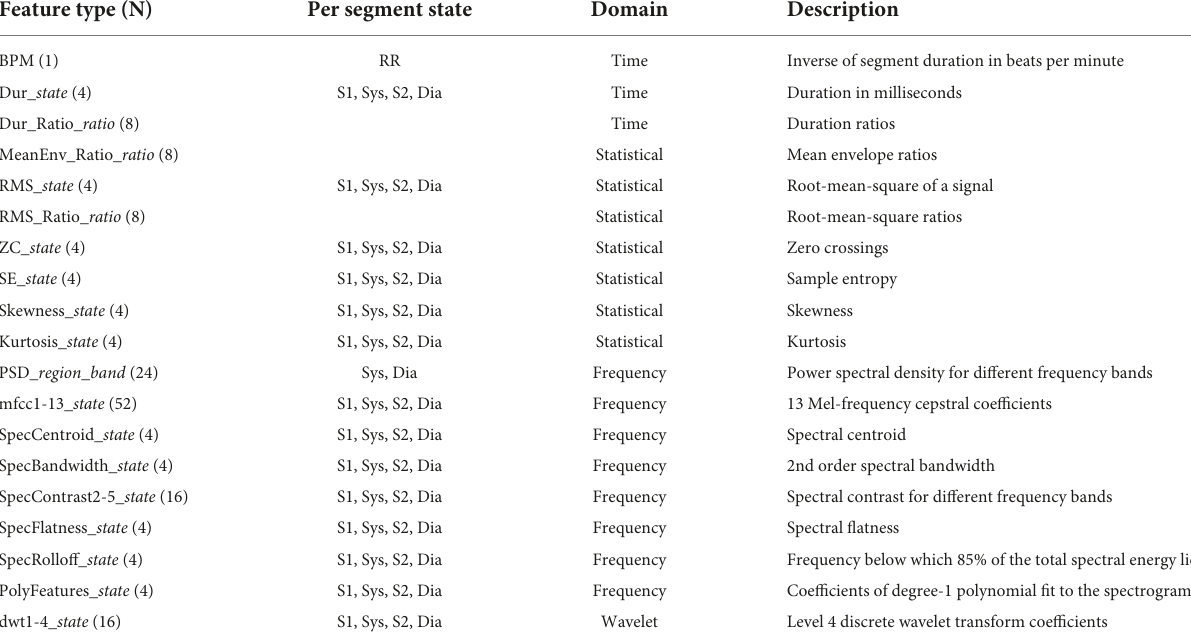
TABLE 2 List of features extracted from the phonocardiograms